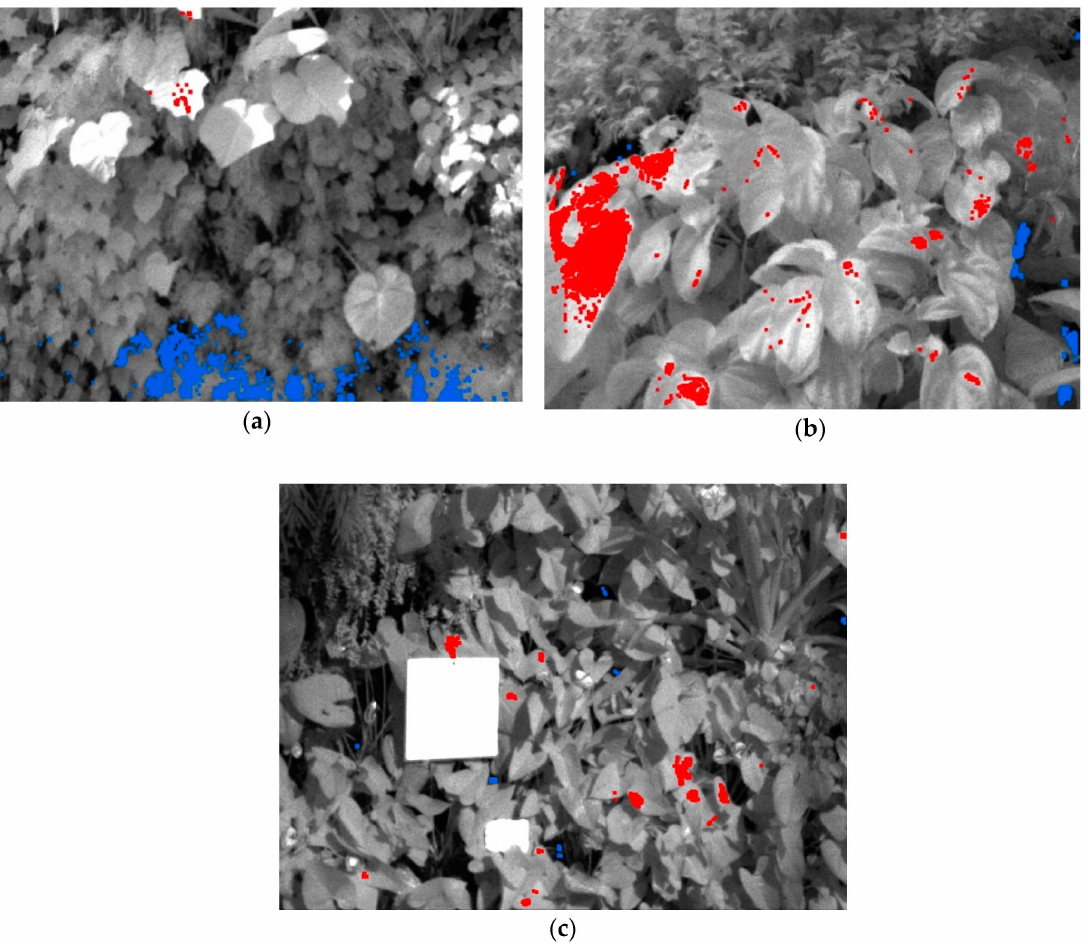
Figure 6. The visualization results of the area associated with dry and wet edges using the multispectral images. ( a ) Site A1; ( b ) Site B1; ( c ) Site C1. Pixels of the dry edge are in red; pixels of the wet edge are in blue. The multispectral images are displayed in the gray-color mode to highlight the colored